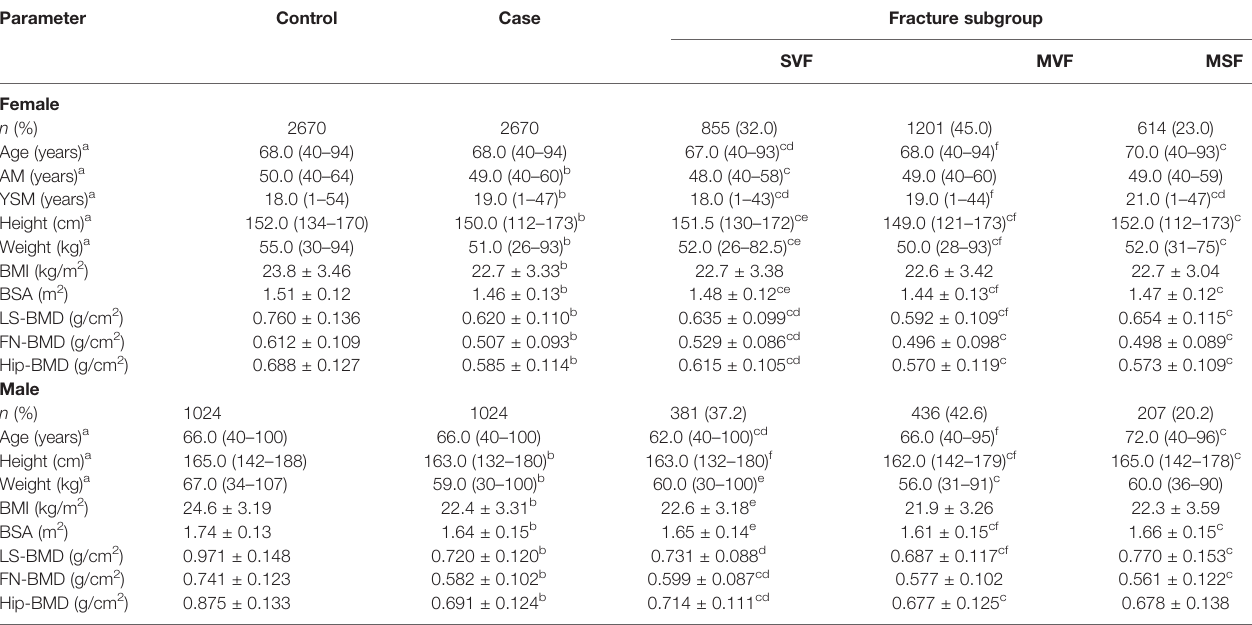
TABLE 1 | Comparison of basic characteristics among cases of fractures and